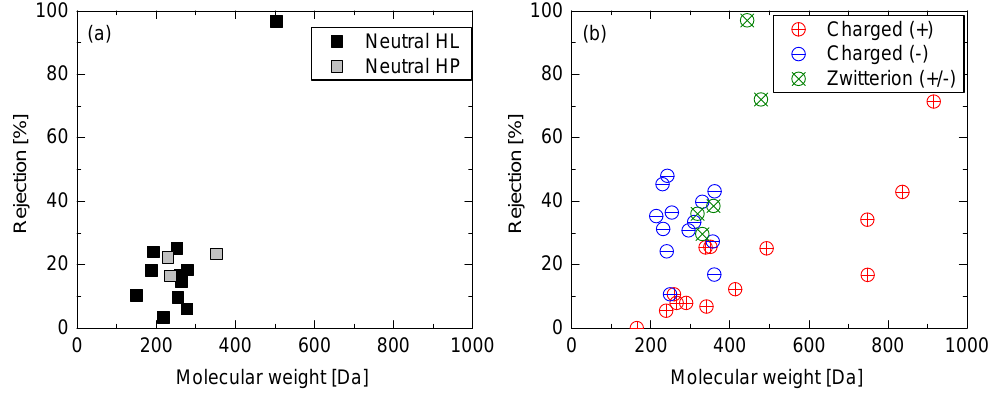
Figure 4. Rejection of ( a ) neutral and ( b ) charged PPCPs by the ceramic NF membrane as a function of their molecular weight.